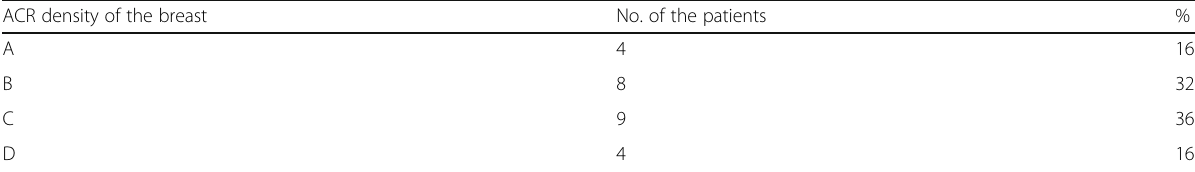
Table 2 ACR density of the breast ACR density of the breast